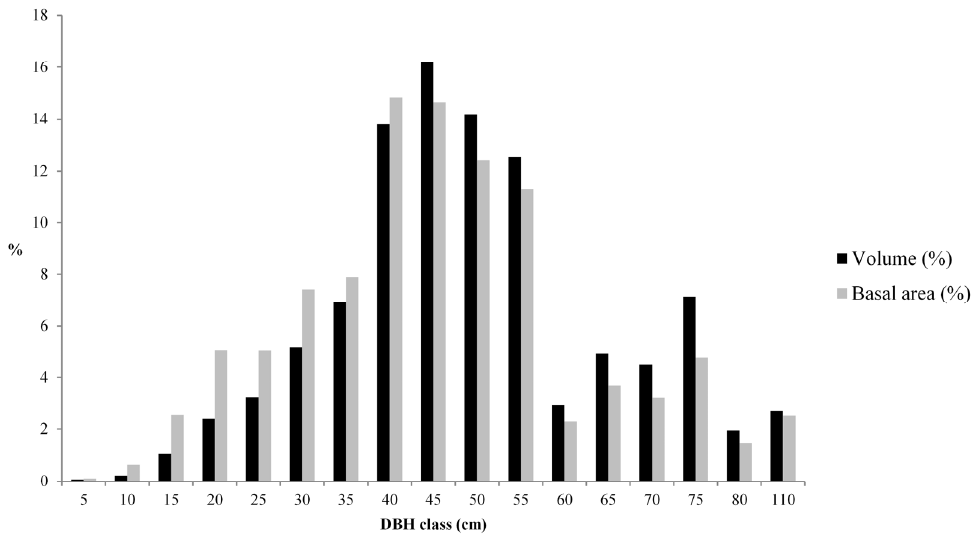
Figure 4. Volume and basal area percentage distribution in DBH classes of all the living stems.